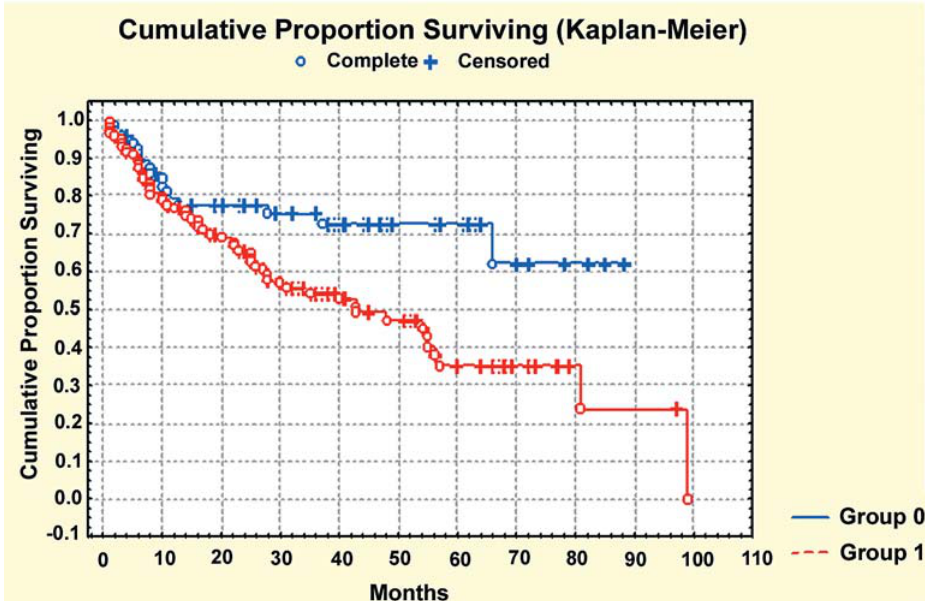
Figure 1 – Time to biochemical (PSA) progression-free survival comparing low-grade (group 0) vs. high-grade (group 1) Gleason score in the surgical specimen. Kaplan-Meier product-limit analysis.